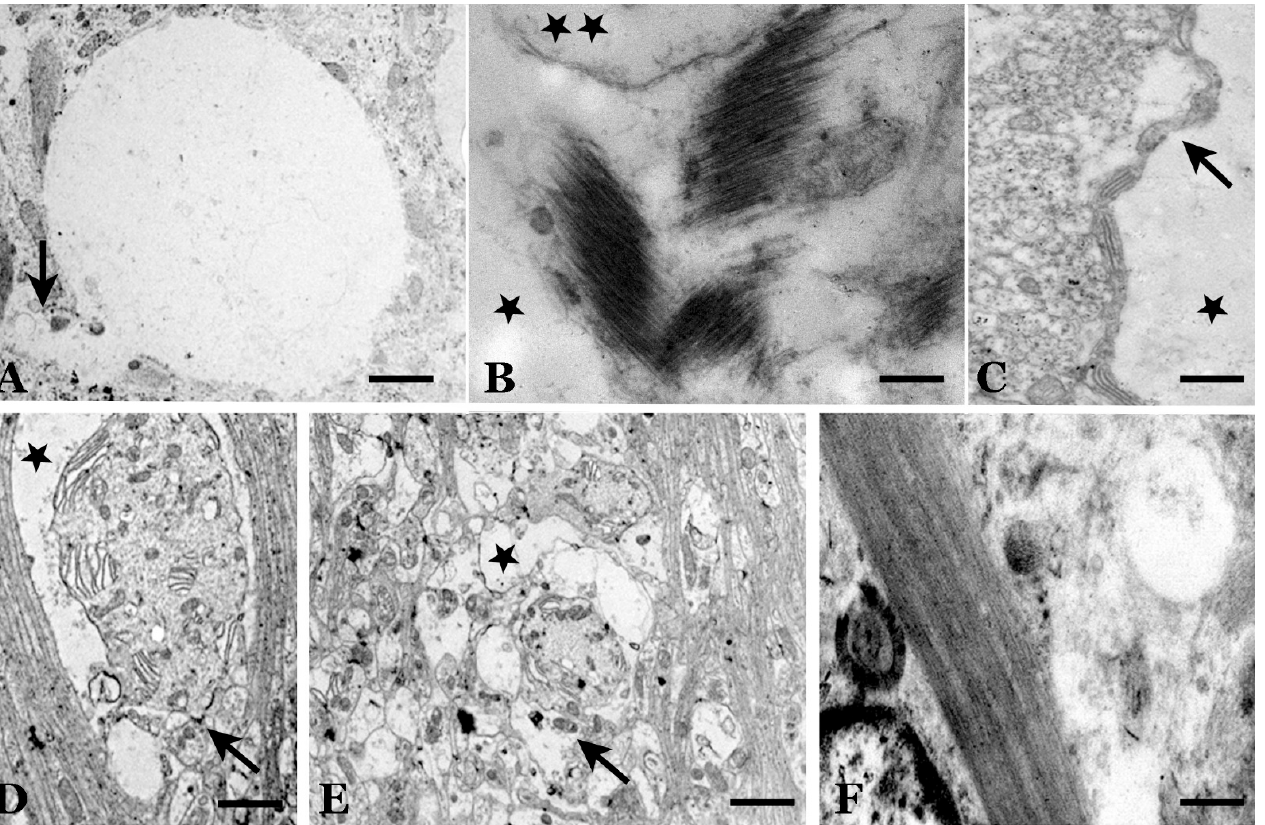
Figure 7. Electron microscopy images of vacuoles (“spongiosis”). ( A ) Large vacuole in a Purkinje cell without an apparent membrane. There seems to be an evagination (arrow, lower left area) towards the surface of the neuron. ( B ) Large (*) and small (**) vacuoles in the neuropil of the molecular layer surrounded by an astroglial process. Vacuole membranes are more or less apparent. ( C ) Large vacuole (*) in the neuropil of the molecular layer surrounded by a thin Purkinje cell dendrite (arrow), defined by accumulation of hypolemmal cisterns. ( B ) and ( C ). Section normal to parallel fibers. ( D ) Large vacuole surrounding a Purkinje dendrite that presents a large accumulation of hypolemmal cisterns but retains synaptic connections with climbing fiber terminals (arrow). ( E ) Various types of medium ‐ sized vesicles surrounding Purkinje cell dendrites (*). Some vesicles lack cellular debris in their interior, but others retain cellular organelle debris (arrow). The latter may be vacuolized Bergmann fibers. ( F ) Hypertrophic astroglia cell with different types of vacuoles and intracellular dense bodies. (Bar: A,C,D = 3.5 μ m; B and F = 1.5 μ m).